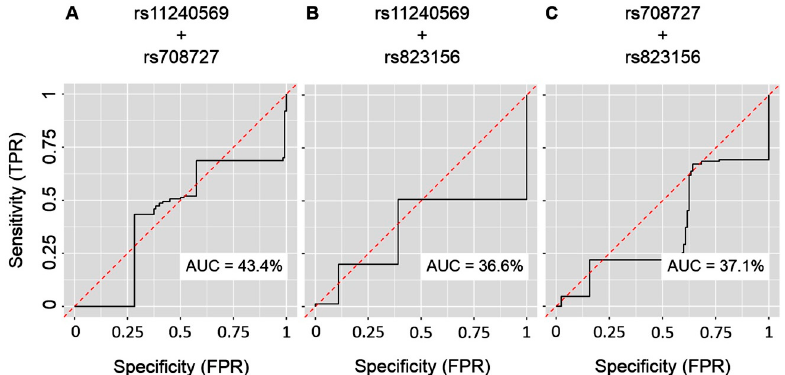
Figure A1. ROC (receiver operating characteristic) curves with the area under the ROC curve (AUC) for the machine-learning Random Forest algorithm with the three individual A1 SNPs (summarized in Table 1) as isolated predictors: ( A ) rs11240569, ( B ) rs708727, ( C ) rs823156. Abbreviations: (TPR) true positive rate, (FPR) false positive rate.